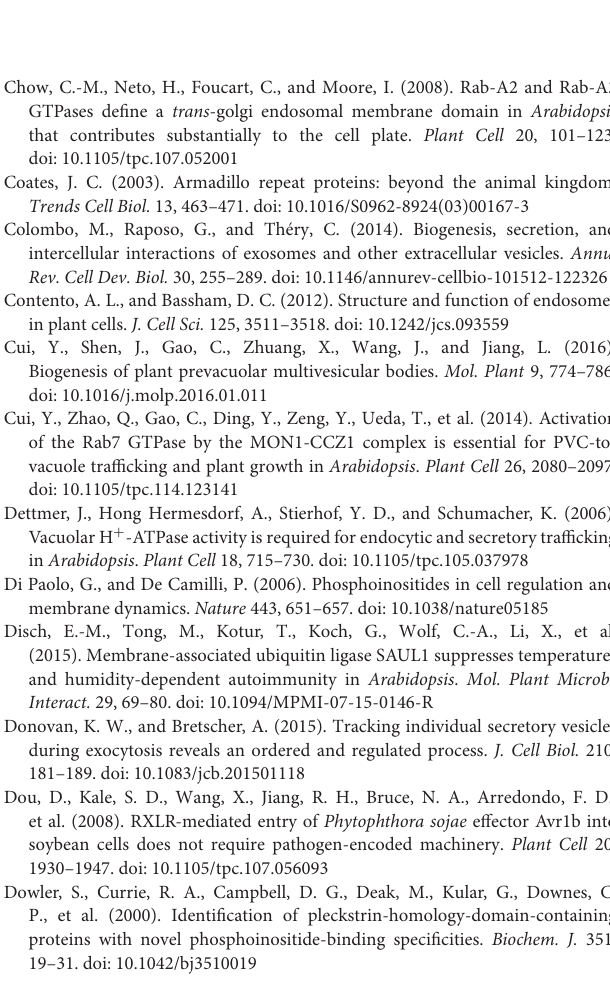
Supplementary Table S1 | Amino acid sequences, plasmid constructs for expression, and other details of protein fusions used in this study. Supplementary Table S2 | Primer